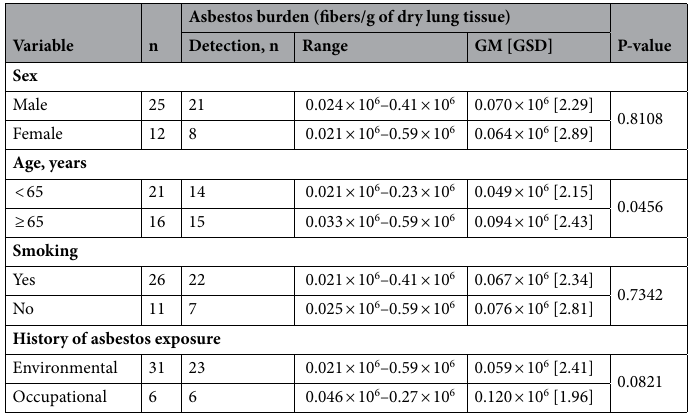
Table 2. Geometric mean values of asbestos burden in lung tissues by sex, smoking, and history of asbestos exposure. GM geometric mean concentrations; GSD geometric standard deviation.